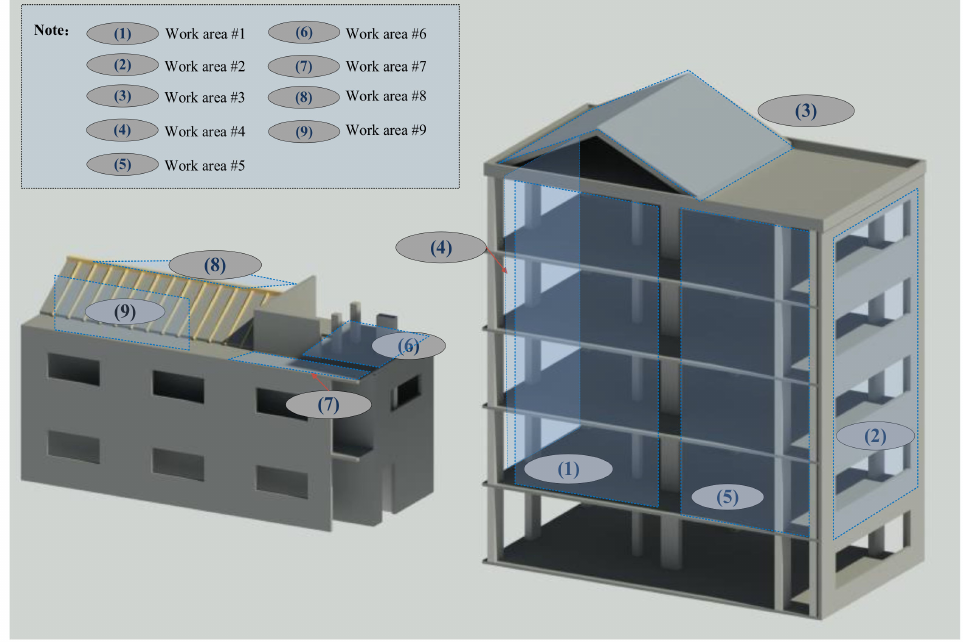
Figure 3. 3D BIM model of the construction project and hazard area